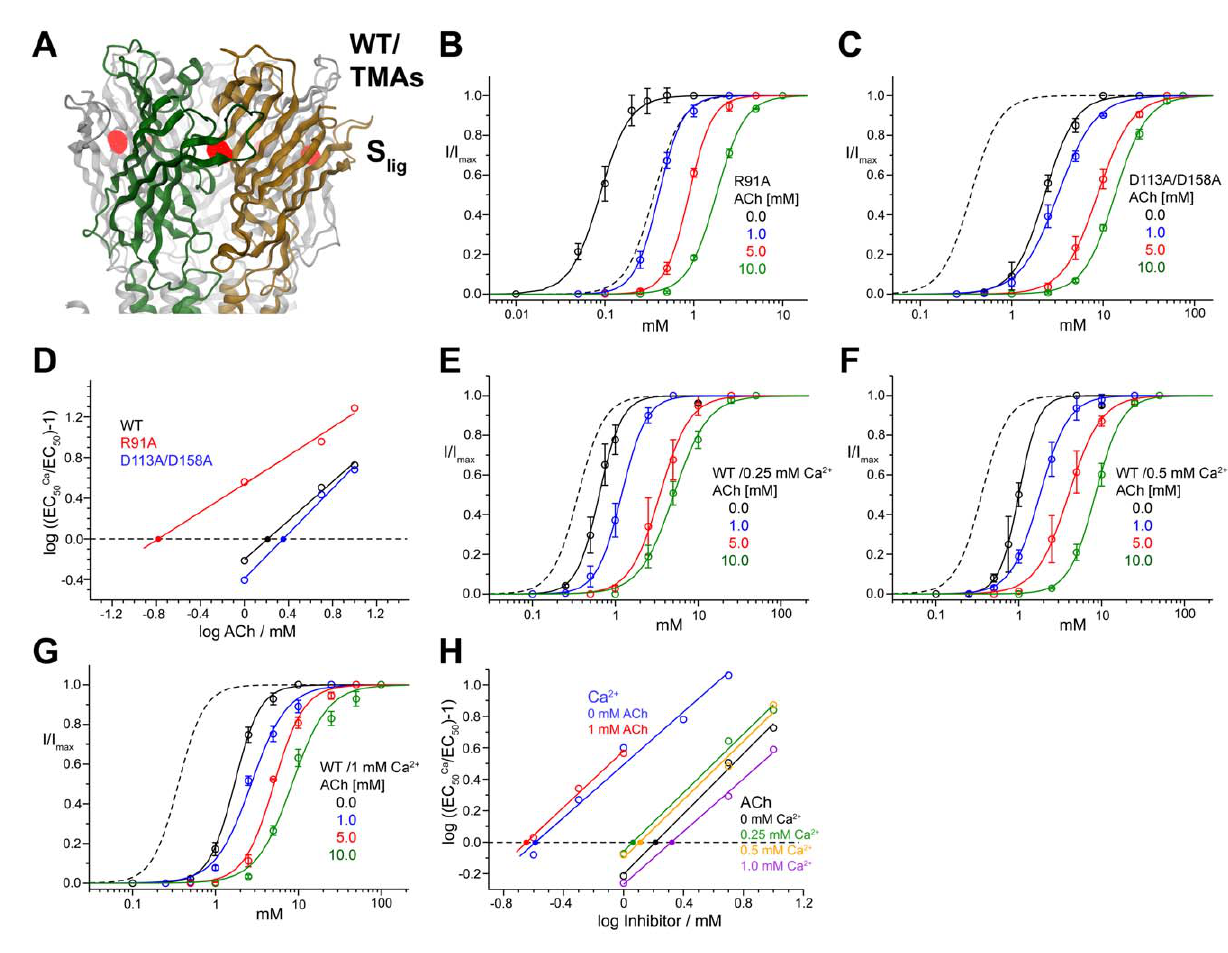
Figure 6. Inhibition by ACh. (A) Anomalous difference electron density (calculated at 5 A˚ and contoured at 6 s ) from data of WT in complex with TMAs is superimposed on a model of ELIC in ribbon representation. The ligand-binding site is indicated. Dose–response relationships upon activation with cysteamine of the ELIC mutants R91A (B) and the double mutant D113A/D158A (C) at different concentrations of ACh. (F) Schild plots quantifying the inhibition of ELIC mutants by ACh. EC 50 values were obtained from data shown in panels (B–C). Dose–response relationships upon activation with cysteamine of WT in the presence of either 0.25 (E), 0.5 (F), or 1 mM Ca 2 + (G). (H) Schild plots quantifying the inhibition of ELIC N mutants by ACh in the presence of Ca 2 + . EC 50 values were obtained from data shown in panels (E–G). Potencies of the antagonists (pA values) were ). The data presented in panels (B–C) and (E–G) are averages from at least obtained by linear regression; the intersection with the x -axis is indicated ( 5 oocytes; errors are SD. The solid lines show fits to a Hill equation. Currents were recorded at 2 40 mV. A dose–response curve of WT in the absence of ACh and Ca 2 + (dashed line) is shown for comparison.